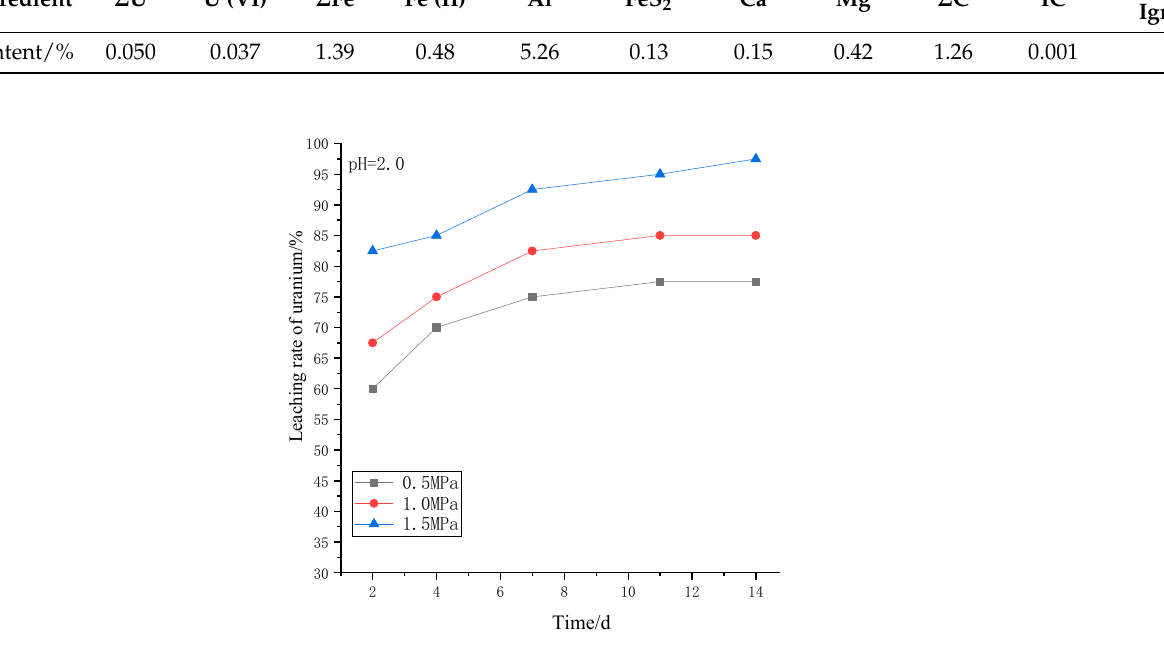
Figure 15. Variation in leaching rate with oxygen pressure (pH = 2.0).